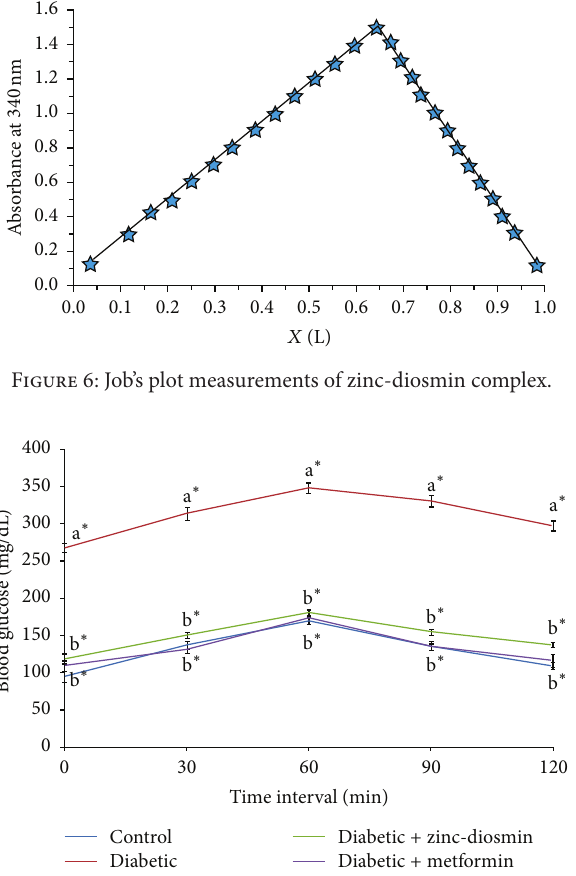
Figure 7: Effect of zinc-diosmin complex on oral glucose tolerance in the experimental groups of rats. Results are expressed as mean ± SEM [ 𝑛 = 6 ]. One-way ANOVA followed by post hoc test LSD was done. The results were compared with a Control rats and b Diabetic rats. Values are statistically significant at 𝑃 < 0.05